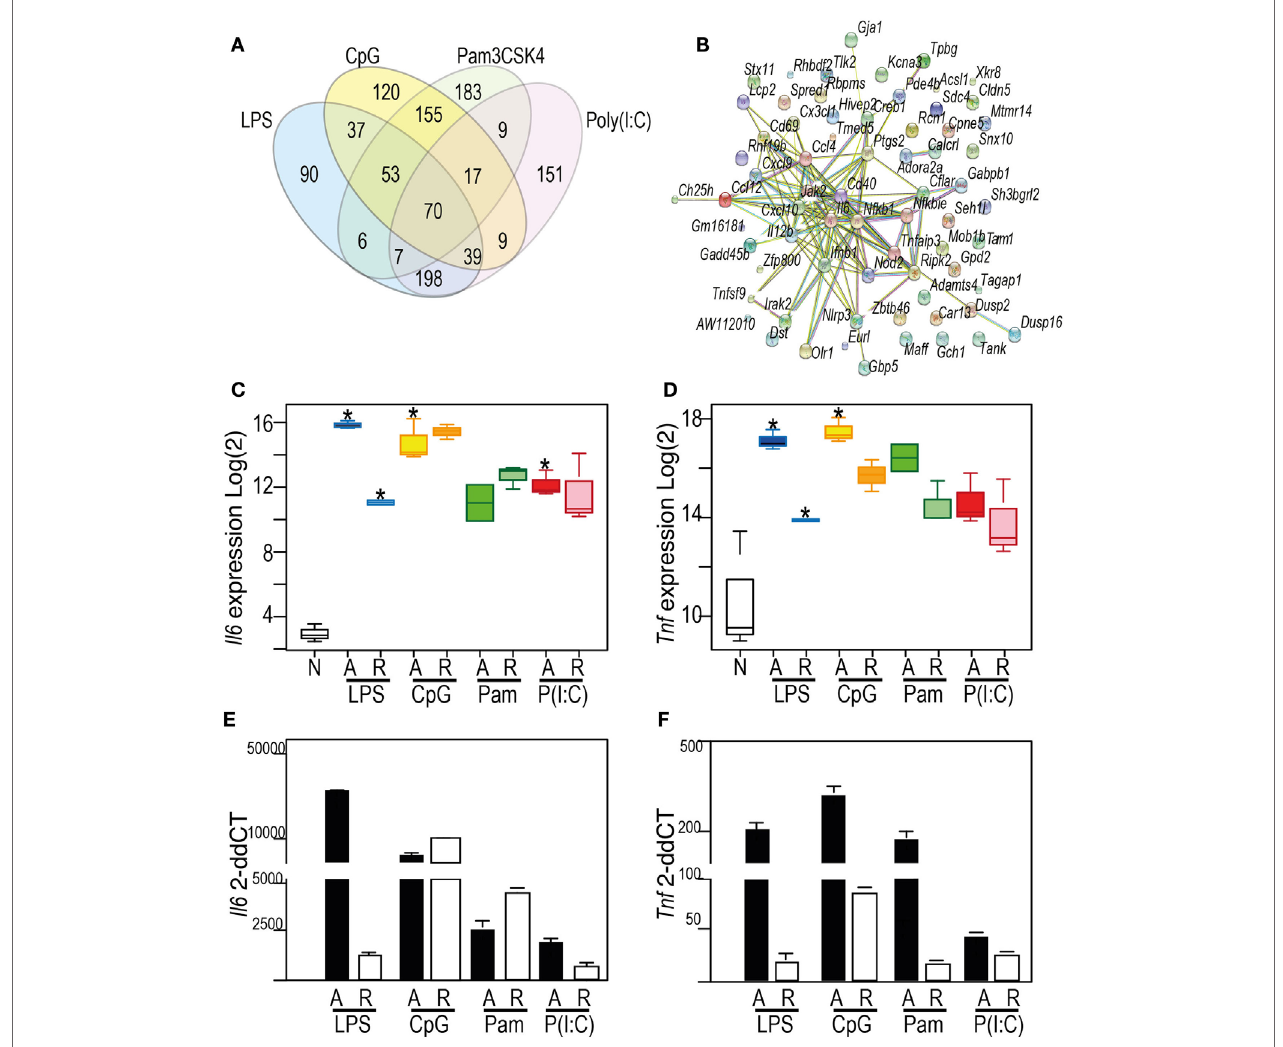
FigUre 2 | Toll-like receptor (TLR) ligands acutely activate macrophages, with shared classes of inflammatory response (a) Venn diagram showing the overlap of the top 500 inducible genes in the acute (4 h) response to: 100 ng/ml lipopolysaccharide (blue), 1 µM CpG (yellow), 100 ng/ml Pam3CSK4 (green), 10 µg/ml Poly(I:C) (red). (B) Protein–protein interaction network derived from StringDB for the proteins encoded by the 70 genes commonly induced by the four TLR ligands indicated in Venn. Nodes: proteins. Edges: interactions from STRING database. (c,D) Patterns of gene expression from the microarray data for Il6 (c) and Tnf (D) mRNA. Y -axis (Log 2 ) expression; X -axis showing naïve (N), acute (A), or re-stimulated (R) bone marrow-derived macrophages (BMDM). (e,F) qRT-PCR measurement of Il6 (e) or Tnf (F) mRNA. Y -axis: microarray (Log 2 ) expression. For Box-whisker plots, median, min, max shown, n = 2 or 3 samples * Benjamini and Hochberg adjusted p < 0.05. For histograms, delta–delta CT normalized to normalized to naïve BMDM, n = 3. See also Supplementary Figure 1: TF motif analysis of top 500 DE